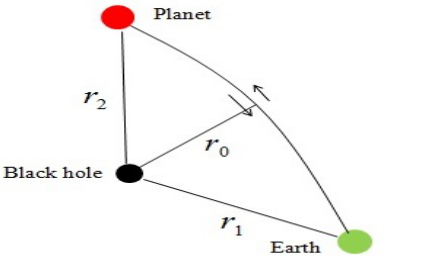
Figure 5. The actual path of the radar reflection of photons from the earth to a planet and